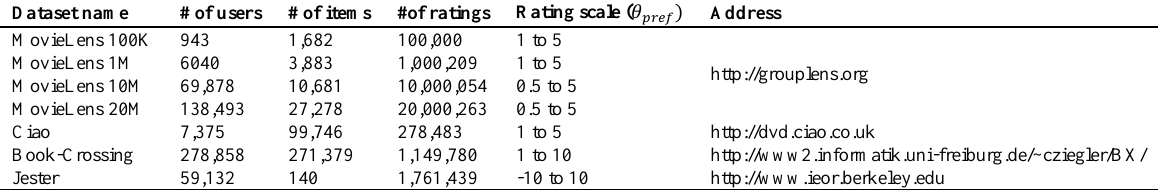
Table 2. Dataset